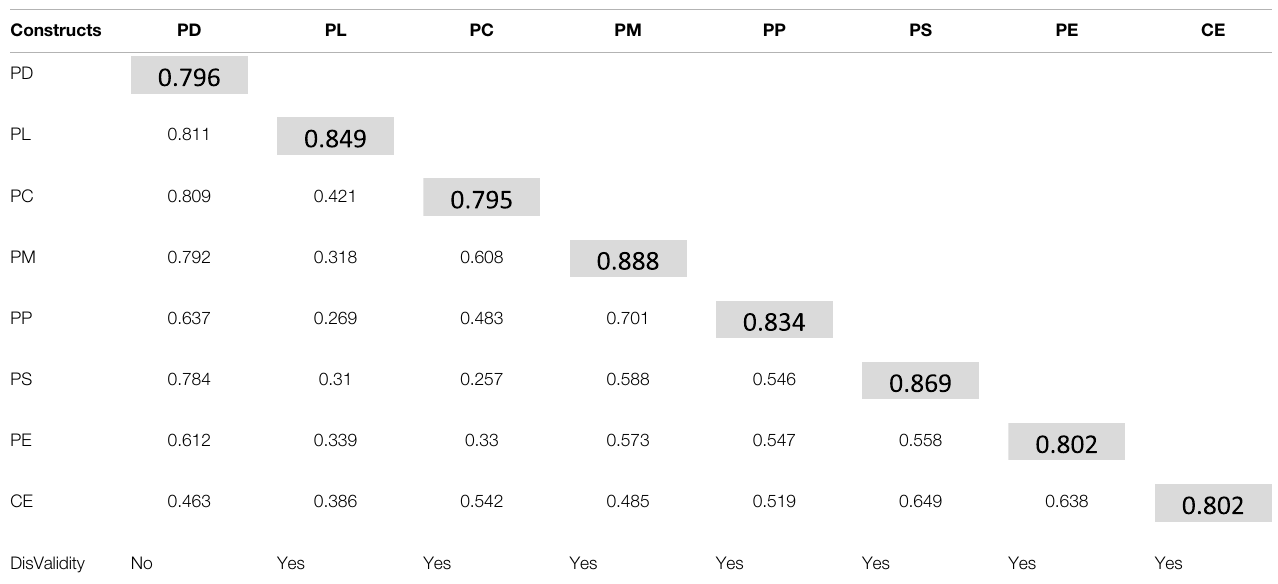
TABLE 6 | Correlation coef fi cient and squared root of AVE for the supplier.